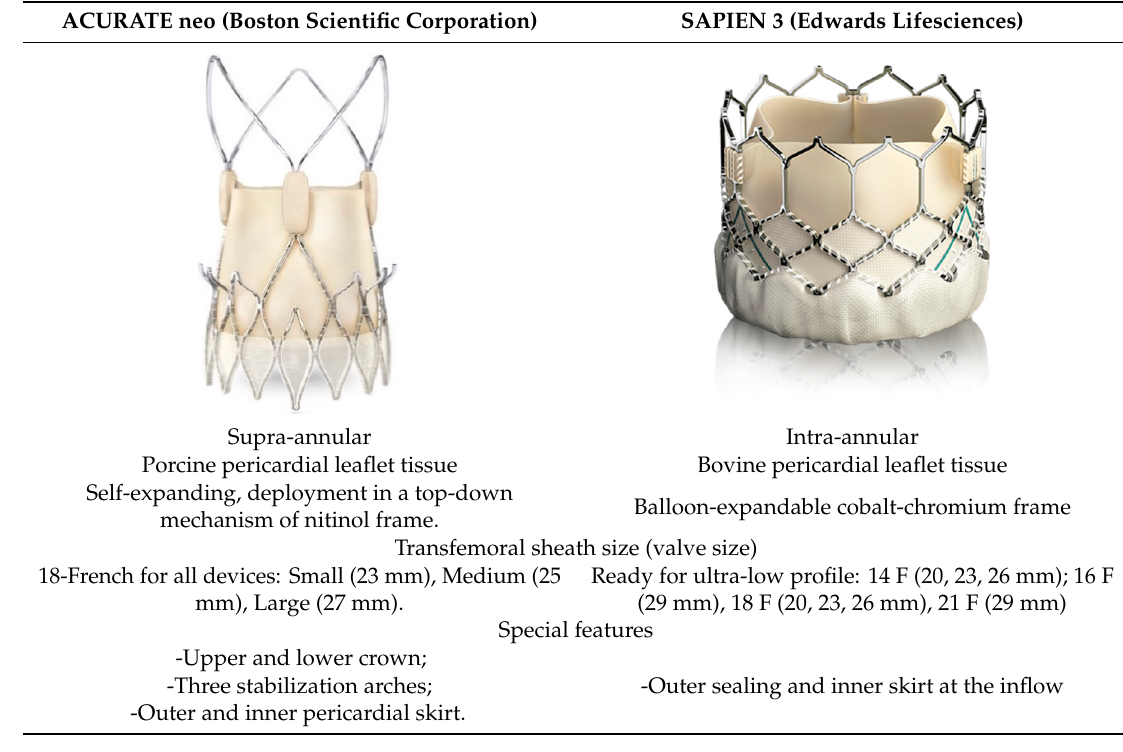
Table 1. Valve characteristics and features.